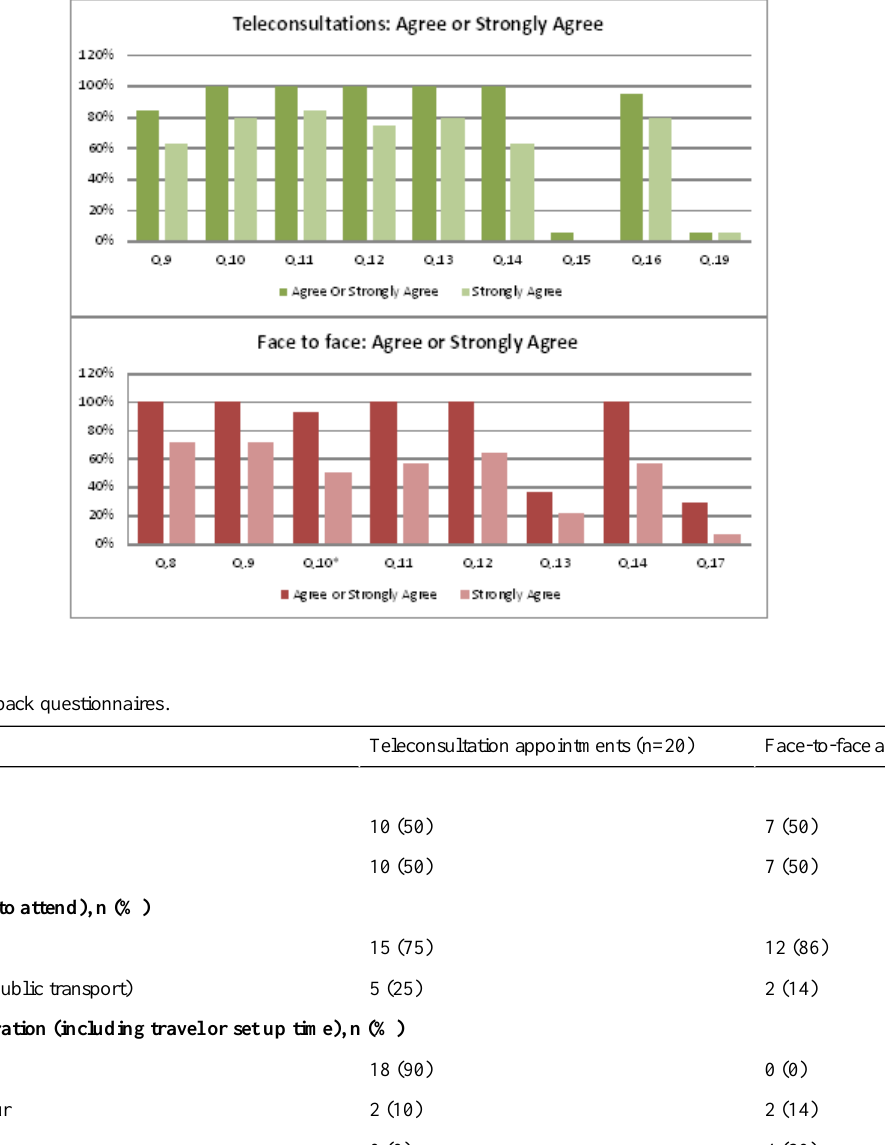
Figure 2. Satisfaction responses in teleconsultation and face-to-face appointment groups.